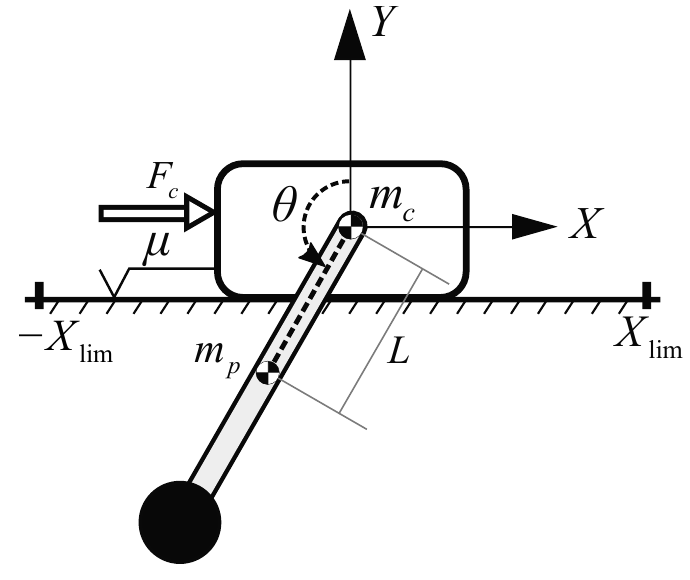
Figure 2. The cart-pole